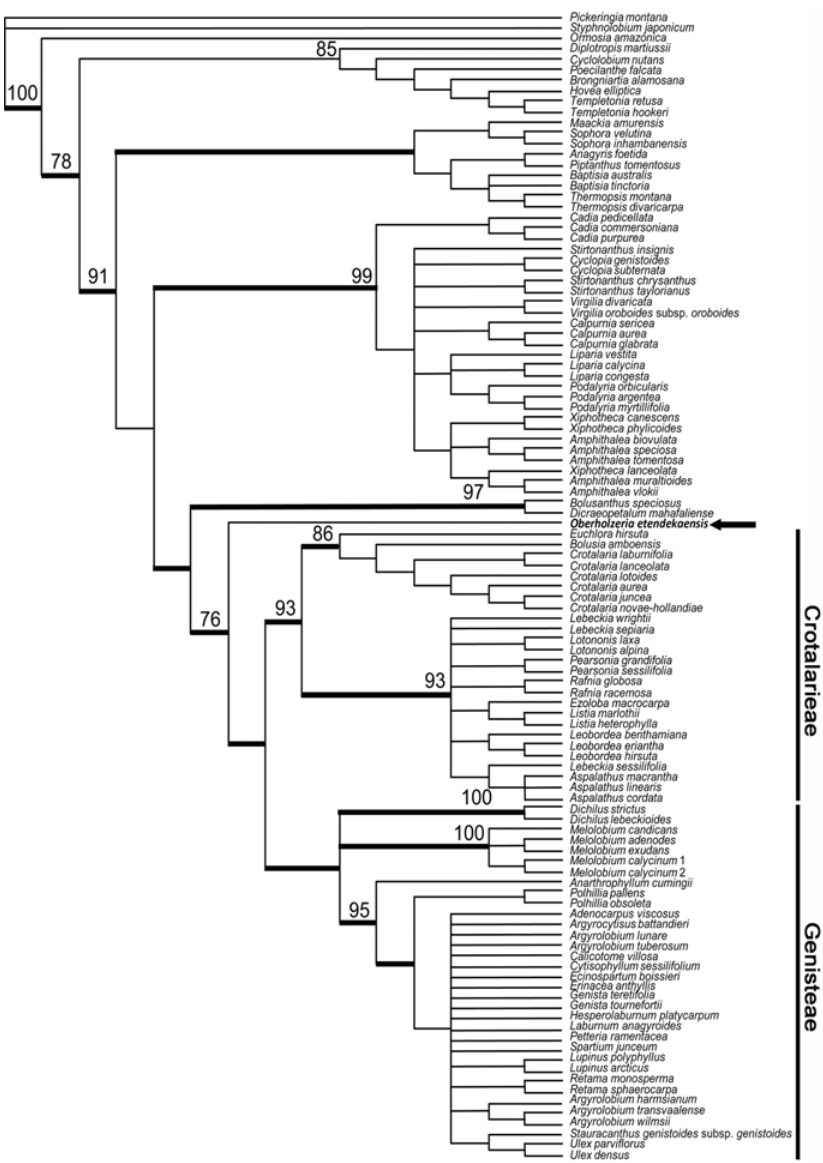
Fig 3. Phylogenetic tree based on nrDNA ITS sequences. Phylogenetic relationship of Oberholzeria etendekaensis (arrowed) derived from maximum parsimony analysis of the nrDNA ITS sequences; 109 taxa, 740 total characters with 639 included, of which 330 (52%) were parsimony informative. Tree shown is strict consensus of > 100,000 equally most parsimonious trees of 1784 steps. Numbers represent maximum parsimony bootstrap support values (100 – 500 replicates) greater than 70% for selected clades; thickened branches represent clades with Bayesian posterior probabilities greater than 0.95. Oberholzeria is supported as the sister to a clade comprised of tribes Crotalarieae and Genisteae (76% and 1.0, respectively).